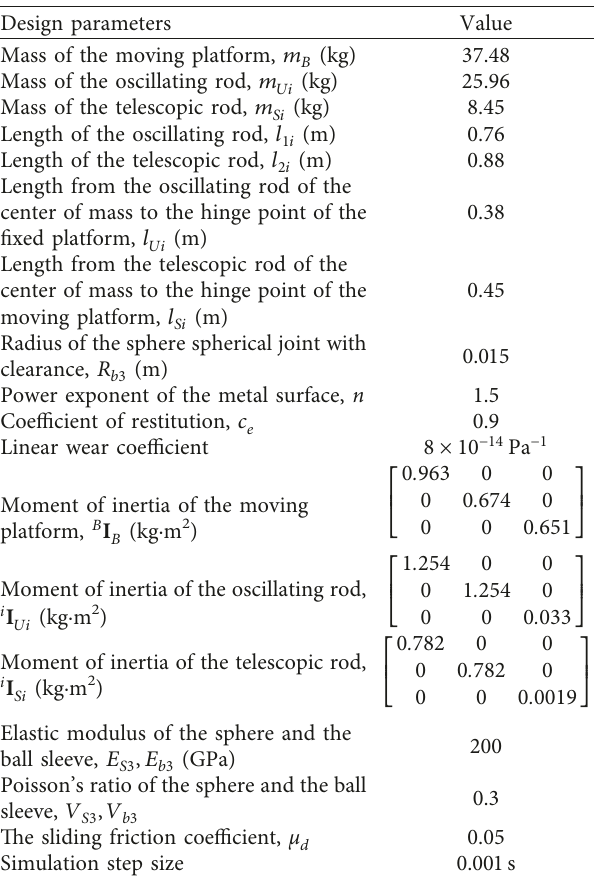
Table 1: System parameters.